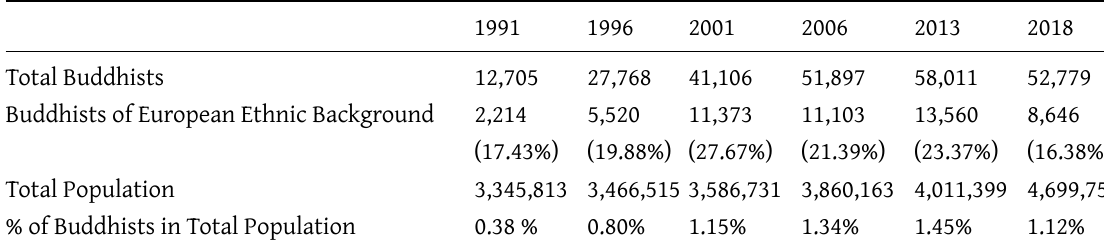
Table 1: Buddhist Population in New Zealand, 1991–2018 (New Zealand Census).